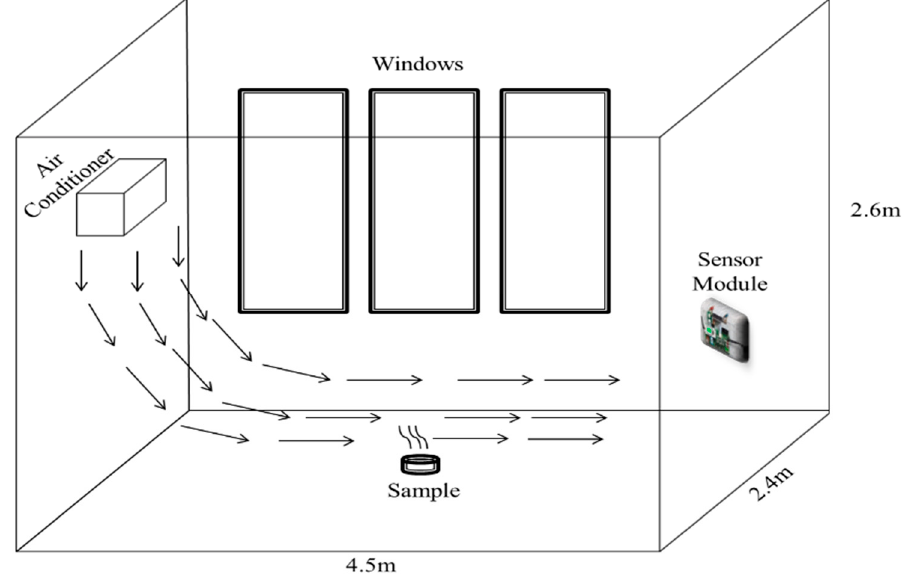
Figure 3. Room setup for the experiment.